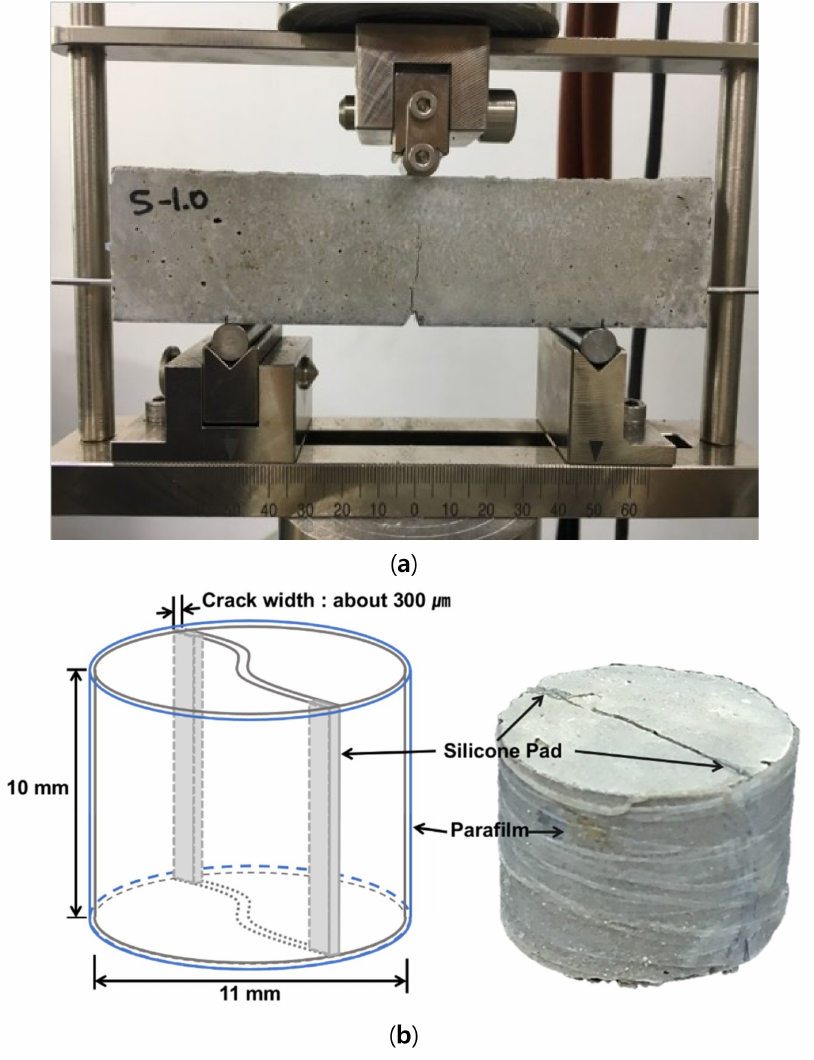
Figure 2. ( a ) Flexural crack-containing specimen for capillary water absorption test; ( b ) cracked specimen for X-ray micro-computed tomography (CT)